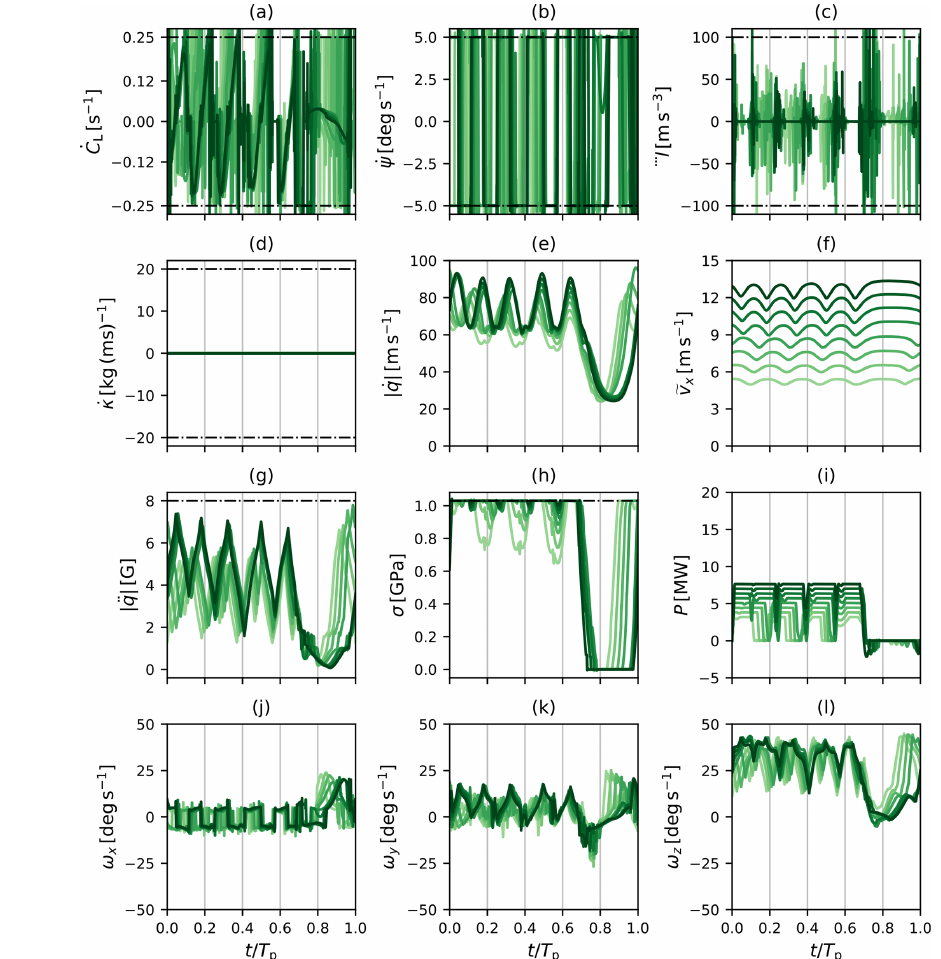
Figure B2. Time series of the controls and additional quantities normalised over one period T p for the large-scale lift-mode AWE system (2) optimised for the wind speed range U D = [ 5 . 0 , 12 . 0 ] . The control variables, i.e. the time derivatives of lift coefficient ˙ C L , roll angle ˙ (cid:57) , and ... l are shown in (a–d) . The magnitude of the flight speed |˙ q | and the streamwise wind speed U x thrust coefficient ˙ κ , and the tether jerk are shown in (e) and (f) . The magnitude of acceleration |¨ q | , the tether stress σ , and the instantaneous power P are shown in (h, i) . The components of the angular velocity ω are shown in (j–l) . The colour scheme is identical to Fig. 3, and the black dashed lines represent the eventual constraints applied to the variables in POCP (Eq.